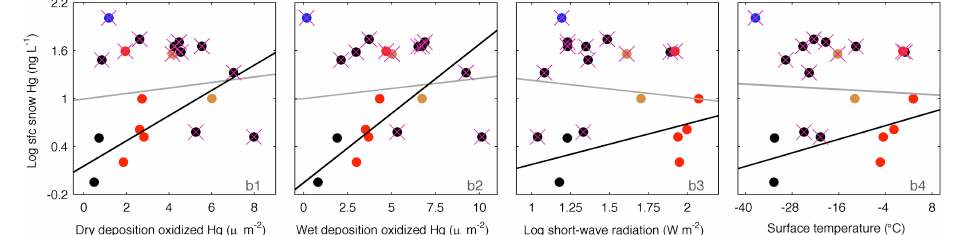
Fig. 4. Scatterplots of sufficiently strongly and significantly correlated model environmental variables with Set2’s concentration of mercury in surface snow. Plotted as per Fig. 3. Additionally, a red “x” overlays mercury observations that are included in Set1 but not